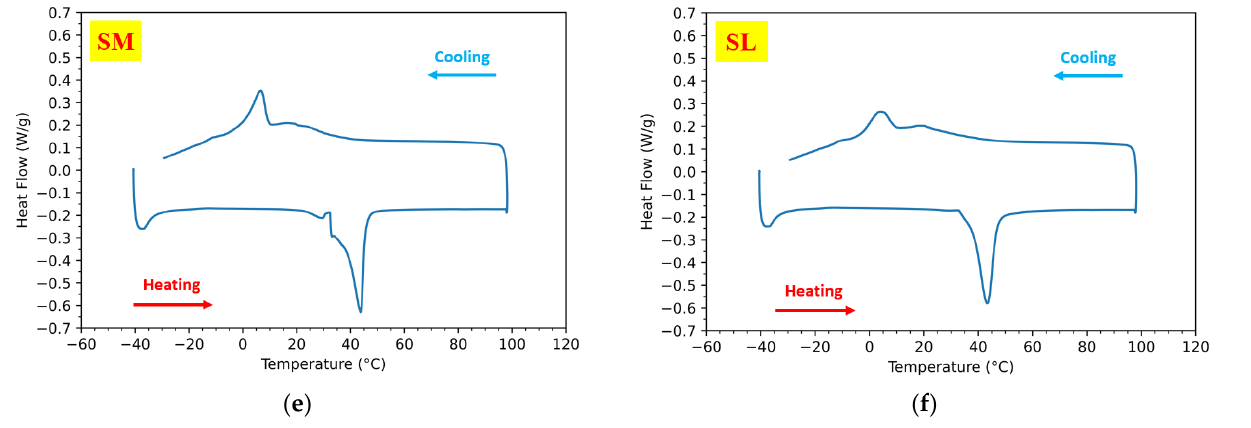
Figure 6. DSC heating–cooling curves of the six regions (marked in Figure 1b) of the as-deposited bi-metallic SMA. ( a ) The upper part of the DED Ti–Ni–Cu alloy (DU). The characterization temper- atures: austenite starting temperature (A s ), austenite peak temperature (A p ), austenite finishing temperature (A f ), martensite starting temperature (M s ), martensite peak temperature (M p ), and martensite finishing temperature (M f ) are labeled. ( b ) The lower part of the DED Ti–Ni–Cu alloy (DL). ( c ) The interfacial region (IN). Notice that there are two distinctive phase-transformation peaks during heating and cooling from Ti–Ni–Cu alloy and TiNi substrate, which are marked by dashed boxes. ( d ) The upper part of the substrate (SU). ( e ) The middle part of the substrate (SM). ( f ) The lower part of the substrate (SL).